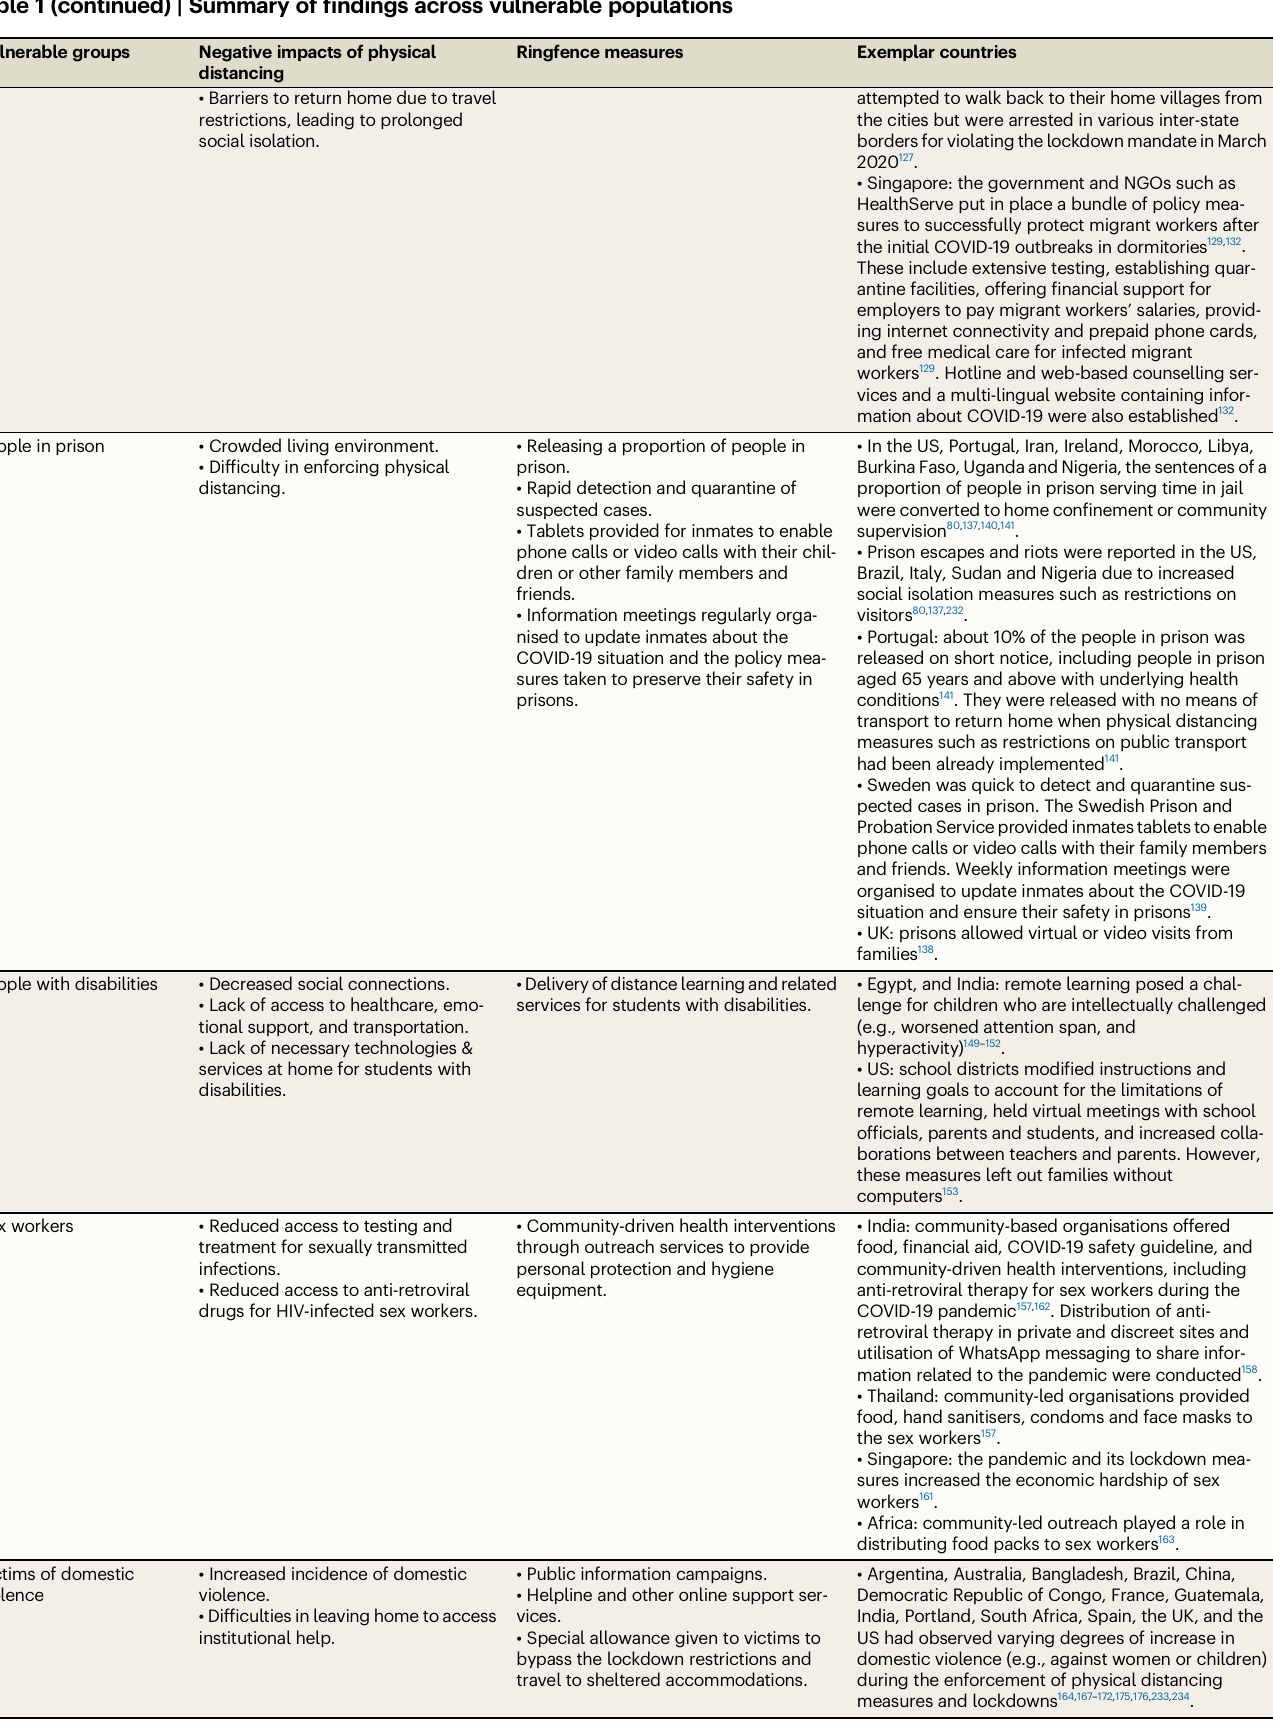
Table 1 (continued) | Summary of fi ndings across vulnerable populations Vulnerable